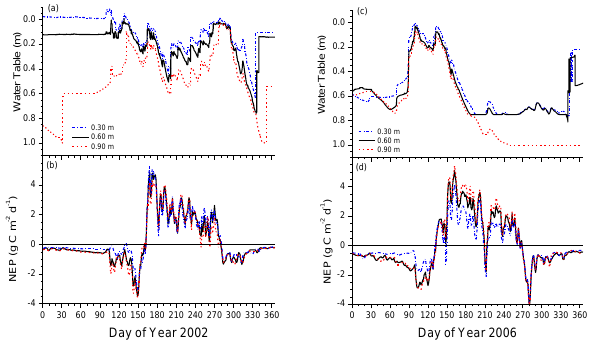
Fig. 9. Changes in water table depth and net ecosystem productivity (NEP) modelled by raising or lowering the depth of the external water table from 0.6m (Fig. 1) to 0.3m or 0.9m in 2002 and 2006. WTD and NEP modelled at 0.6m are the same as those in Fig. 2.